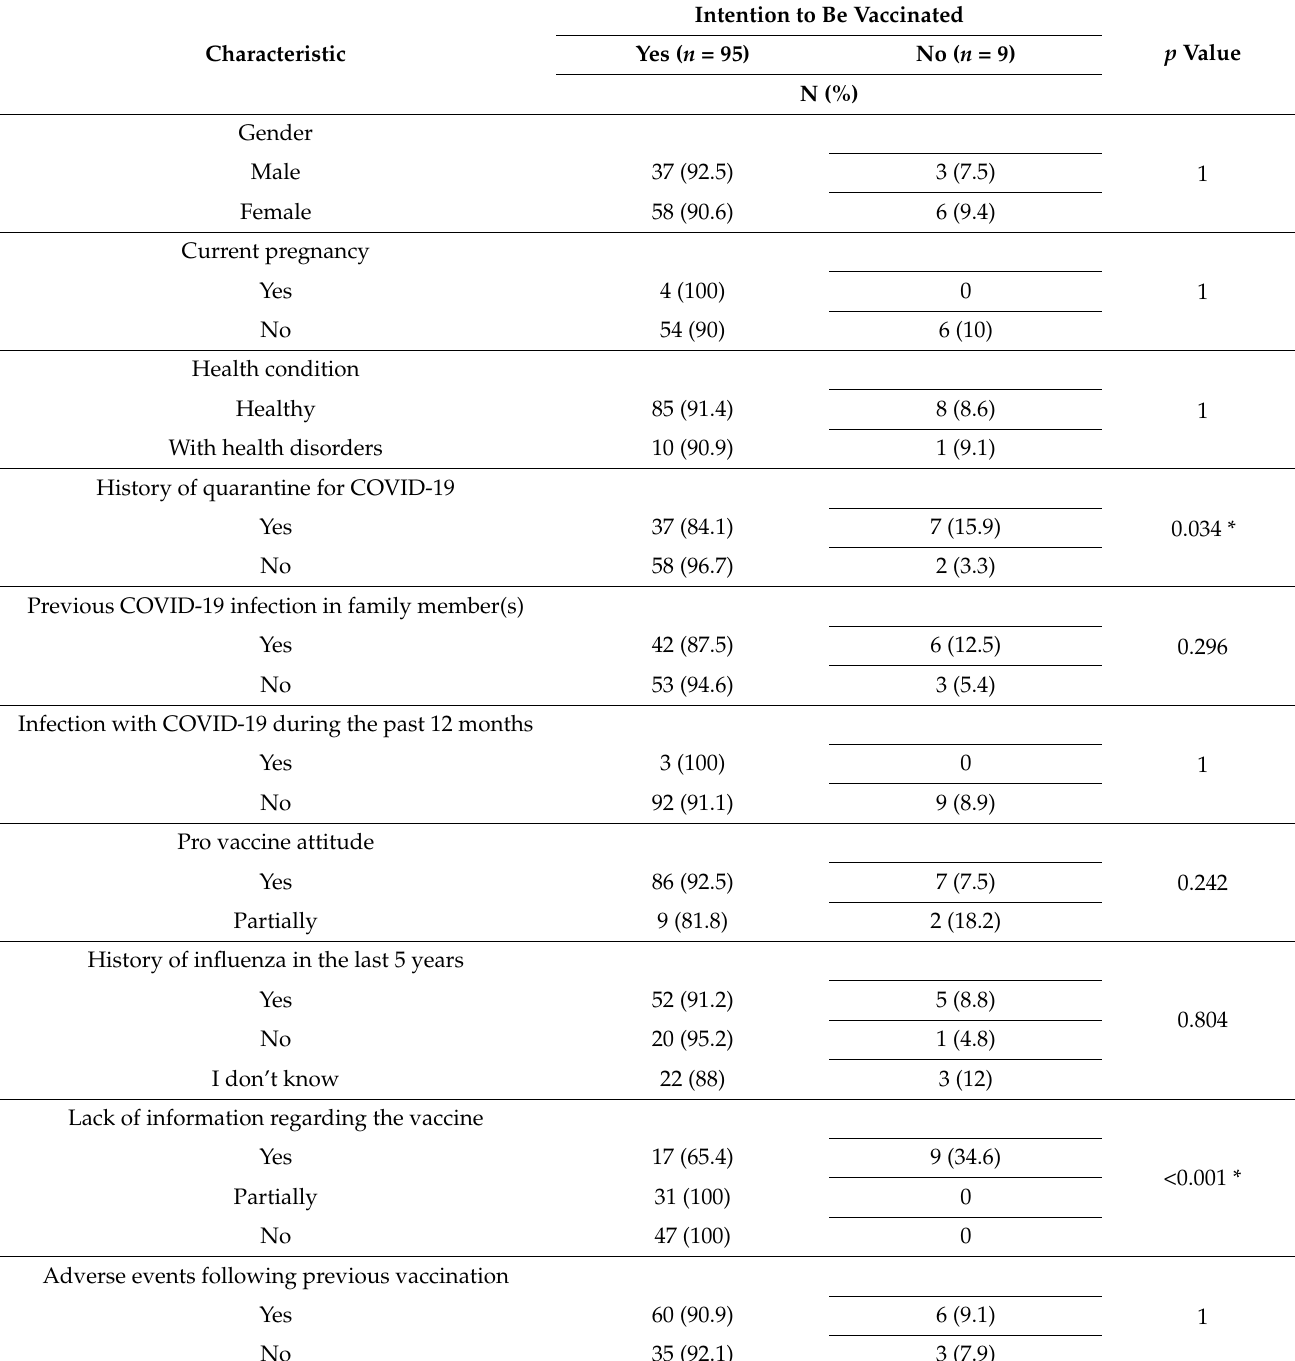
Table 2. Associations between background factors and the intention to be